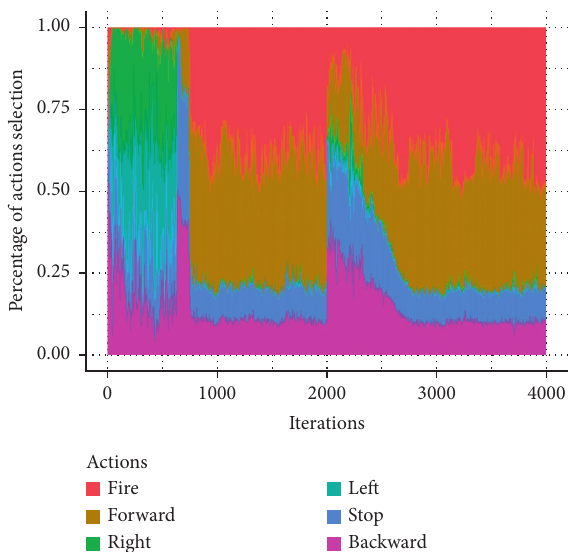
Figure 6: Percentage of actions selected during model training in combat with the Robot